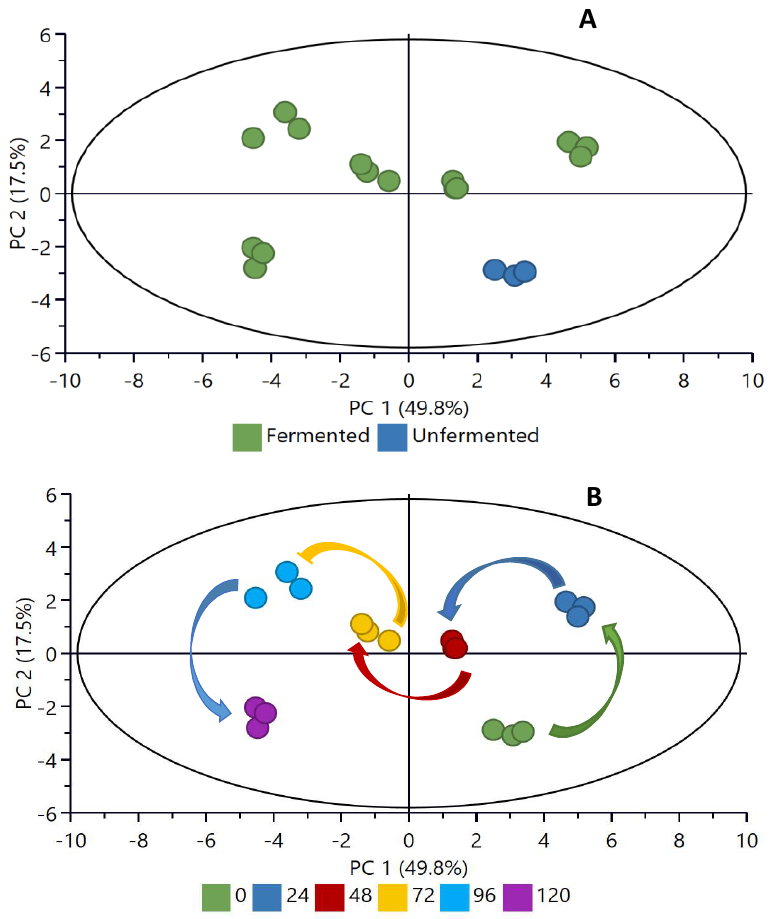
Figure 7. Exploratory data analysis with PCA. ( A ) Relationship of unfermented and fermented samples; ( B ) relationship of samples fermented at different times.